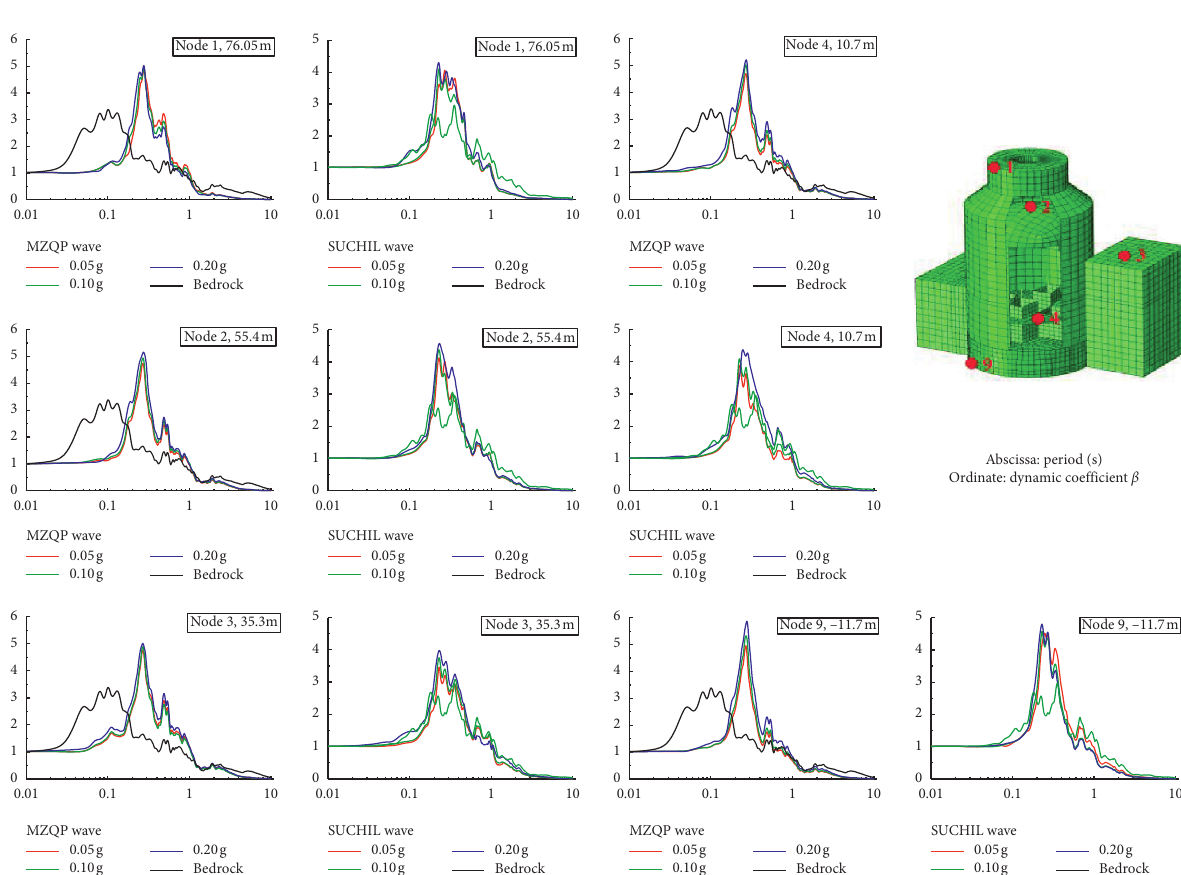
Figure 11: FRS of the nuclear island structure observation